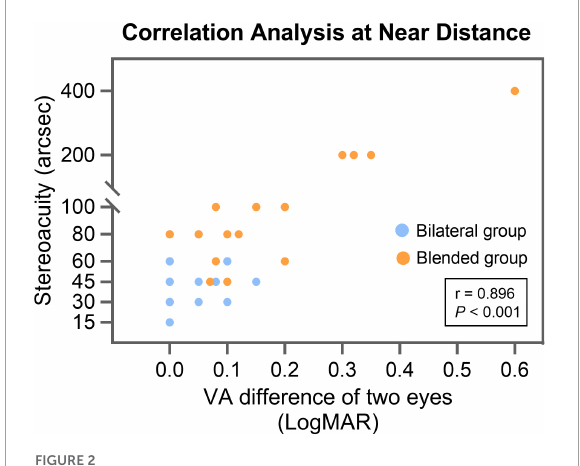
FIGURE2 The correlation analysis between VA difference of two eyes and stereoacuity for all patients at near distance (40 cm). arcsec = seconds of arc; LogMAR = logarithm of the minimum angle of resolution; VA = visual